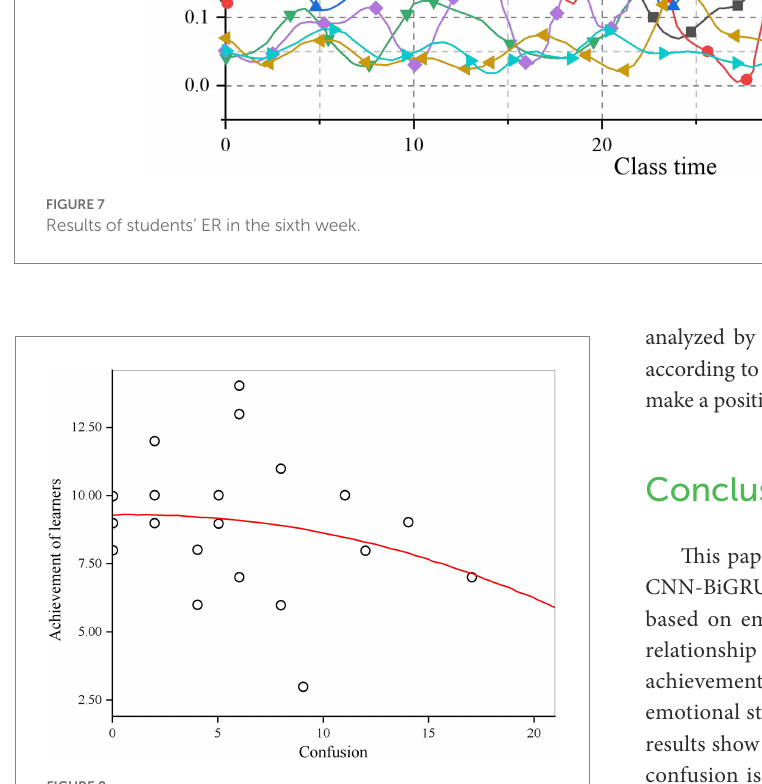
FIGURE 8 Fitting curve between learners’ confusion and